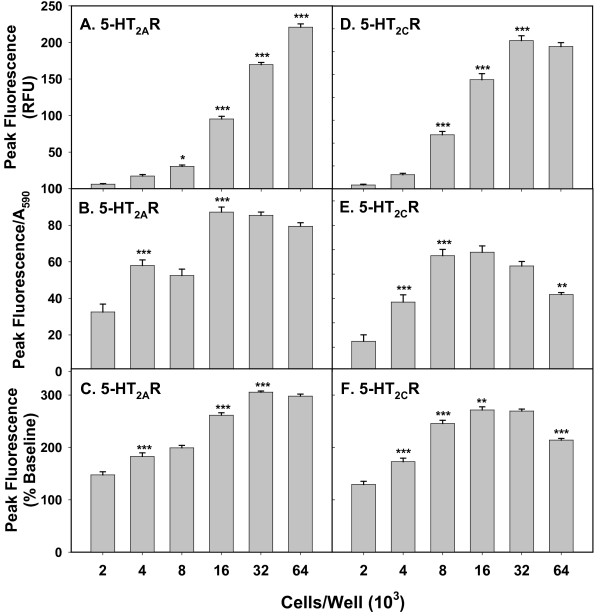
Effect of plating density on Cai++ response to ligand stimulation of 5-HT2AR-CHO (A-C) and 5-HT2CR-CHO cells (D-F). Cells were plated at indicated densities, loaded with Calcium 4 and stimulated with 1 μM 5-HT. (A, B) Raw peak fluorescence, expressed as relative fluorescent units (RFUs). (C, D) Cell number was estimated by staining with crystal violet and fluorescence normalized to A590. (E, F) Fluorescence was normalized to baseline fluorescence of each individual well. Graph is representative of three independent experiments. n = 7-8; * p < 0.05, ** p < 0.01, *** p < 0.001 vs. previous bar.